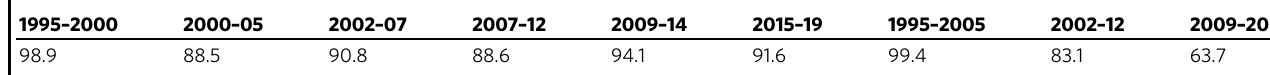
Table 3 Percentage of constrained portfolios that outperform unconstrained ones in Sharpe